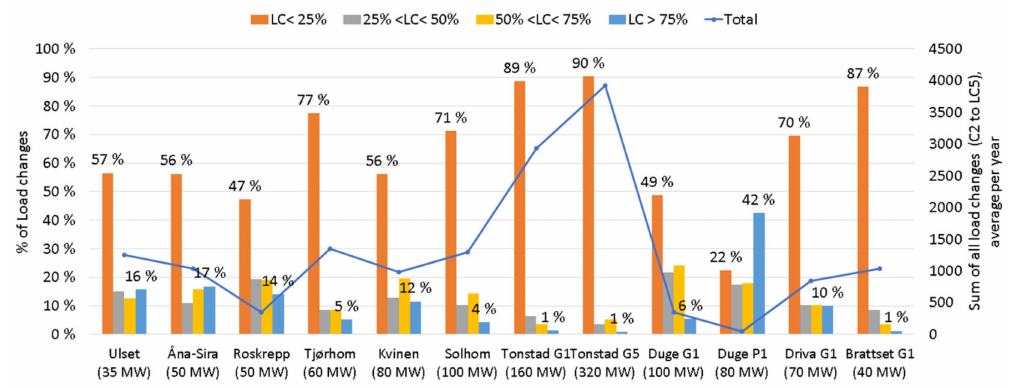
Figure 5. Percentage of load changes of different